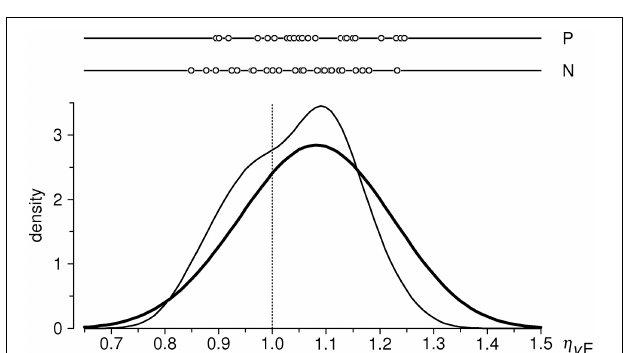
FIGURE 3 | Distributions of aggregated ratio indices a P and a N in the entire sample ( n = 31 subjects). Upper part: individual data points; below: estimates of probability density functions (thin curve: a N , thick curve: a P ), obtained with a Gaussian kernel (Silverman, 1986) of bandwith σ = 0 . 04. Vertical dotted line indicates the null-hypothesis-based expectation.